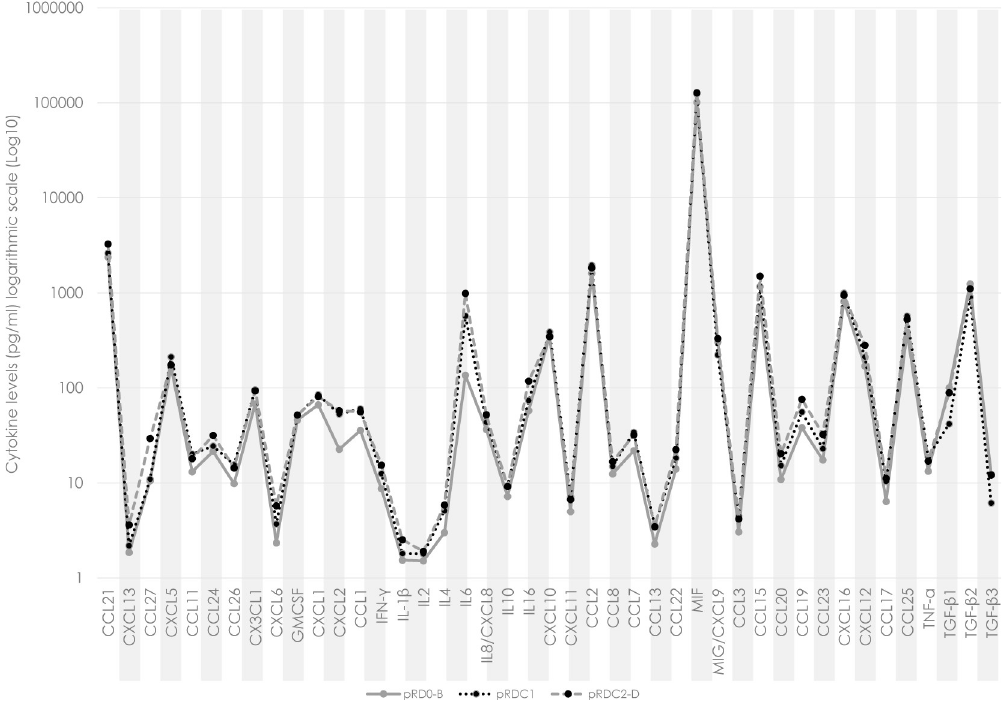
Fig 3. Cytokine levels in the vitreous fluid regarding different PVR grades Cytokine levels in the vitreous (VF) of eyes with primary retinal detachment without PVR or PVR grades A or B (pRD0-B; n = 81 ) with PVR grade C1 (pRDC1; n = 27 ) and grades C2-D (pRDC2-D; n = 65